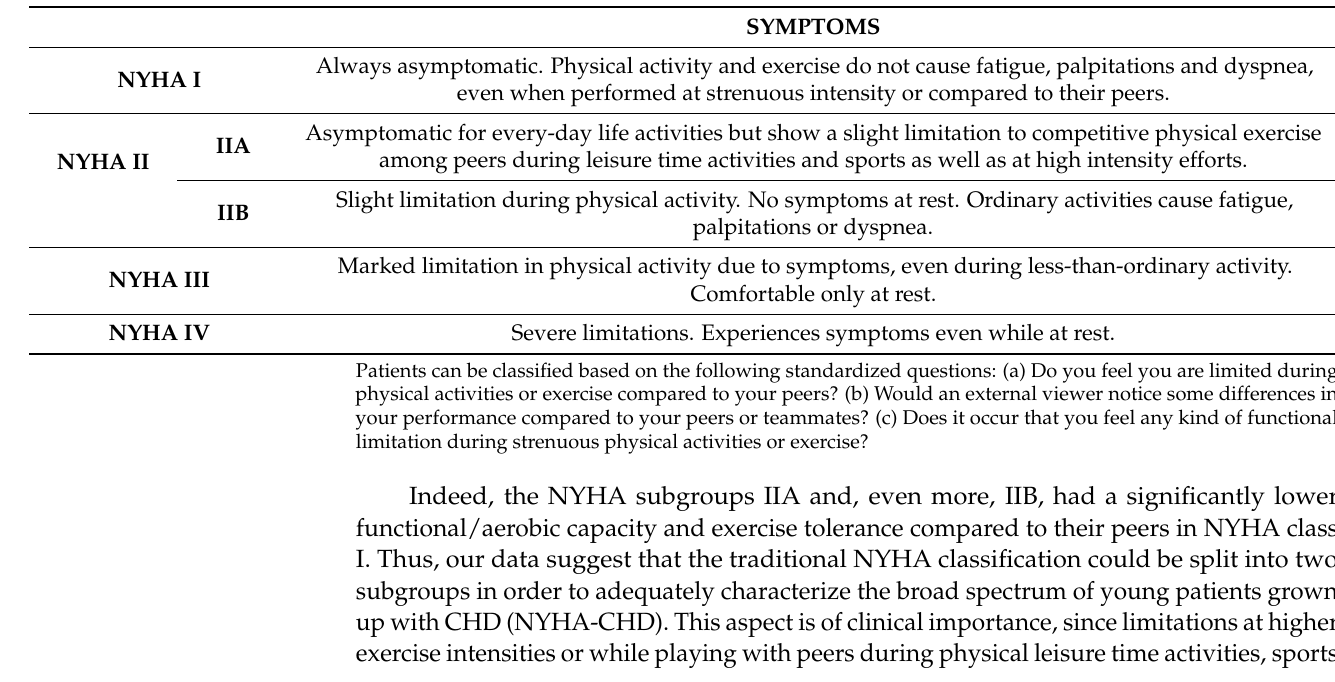
Table 2. The proposed adapted NYHA-CHD classification for children with congenital heart disease.